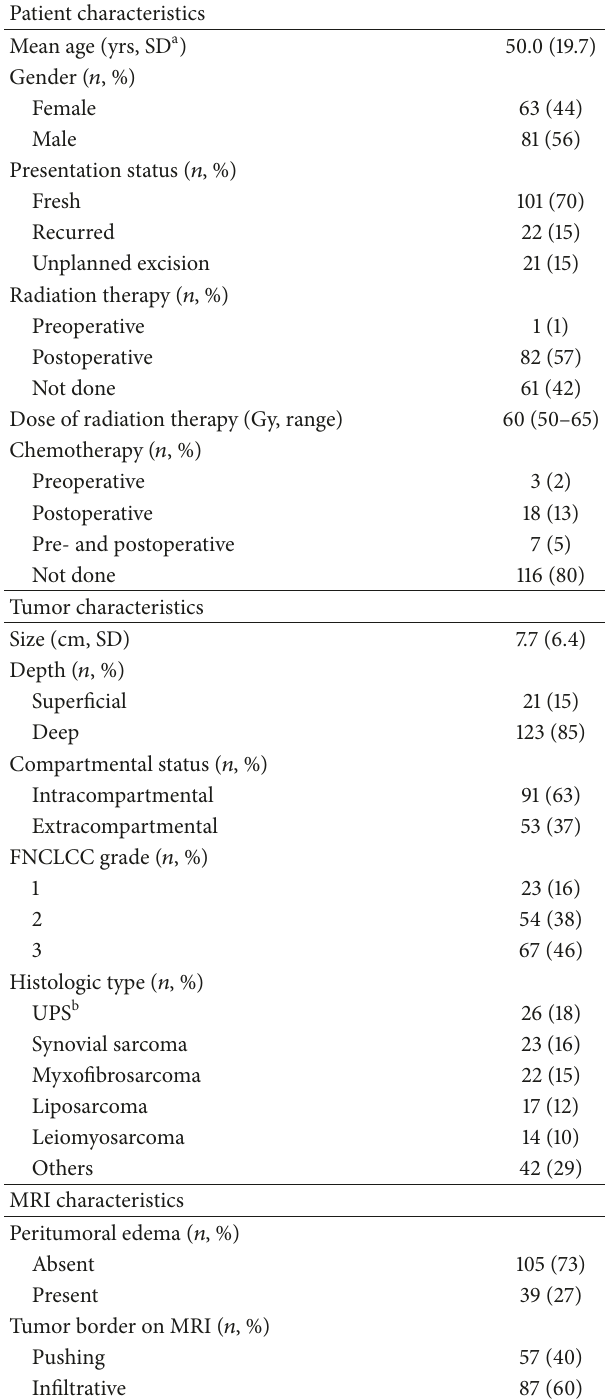
Table 1: Preoperative